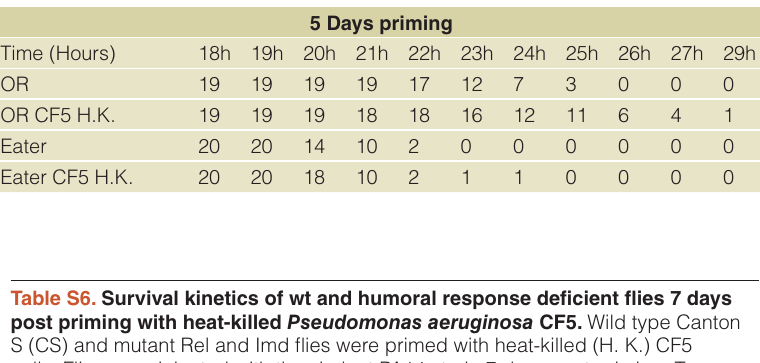
Table S6. Survival kinetics of wt and humoral response deficient flies 7 days post priming with heat-killed Pseudomonas aeruginosa CF5. Wild type Canton S (CS) and mutant Rel and Imd flies were primed with heat-killed (H. K.) CF5 cells. Flies were injected with the virulent PA14 strain 7 days post priming. Top row numbers indicate the time in hours post injection whereas lower rows indicate the corresponding number of surviving flies in naive and primed flies respectively for each genotype. Sample size is indicated at 18h.